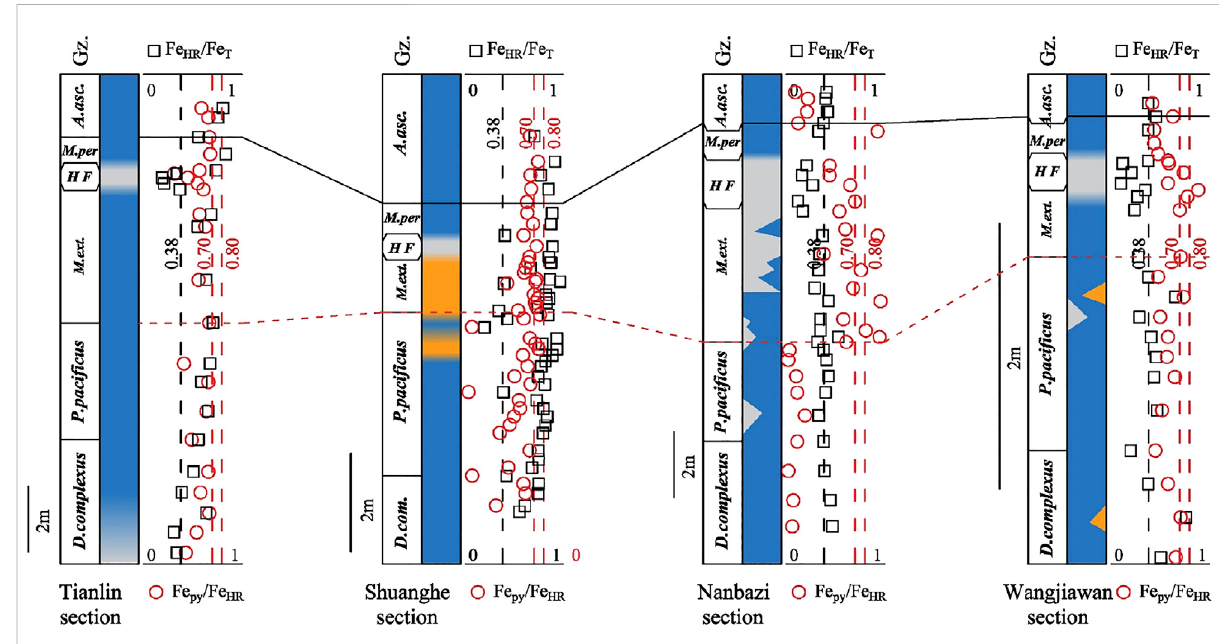
FIGURE 6 Redox condition correlations for the study sections. Data of the Shuanghe section, Nanbazi section, and Wangjiawan section can be found in previous studies (Yan et al., 2009b, 2012; Liu et al., 2016; Li et al., 2017b; Li N et al., 2021; Li Y et al.,